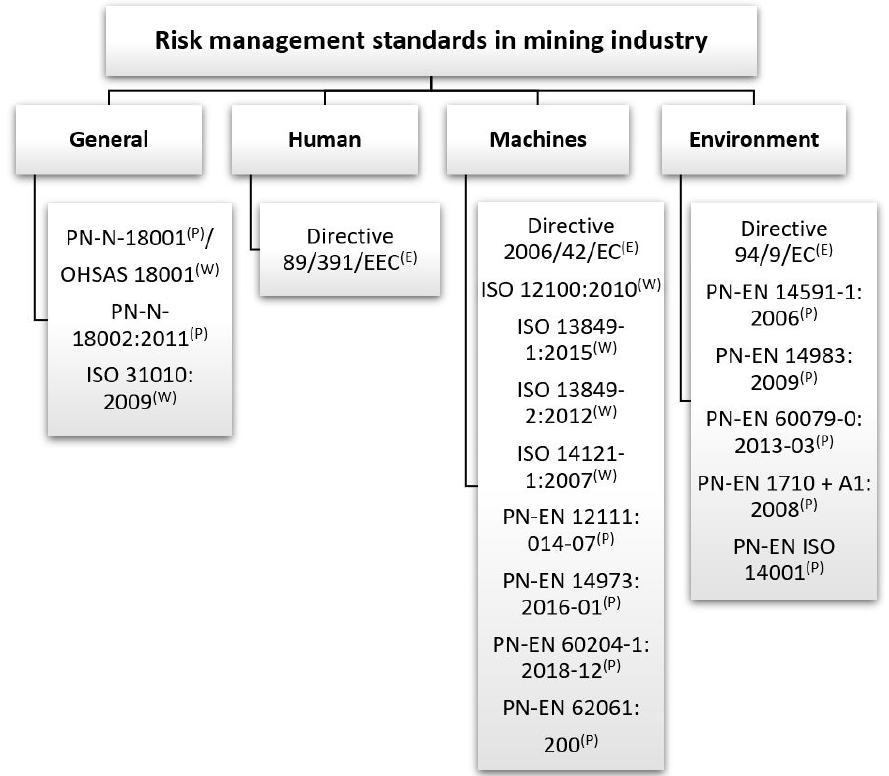
Figure 2. Classification of the main risk-related standards for the mining sector (where: (W)—global scope of application, (E)—standards applicable in Europe, (P)—standards applicable in Poland).